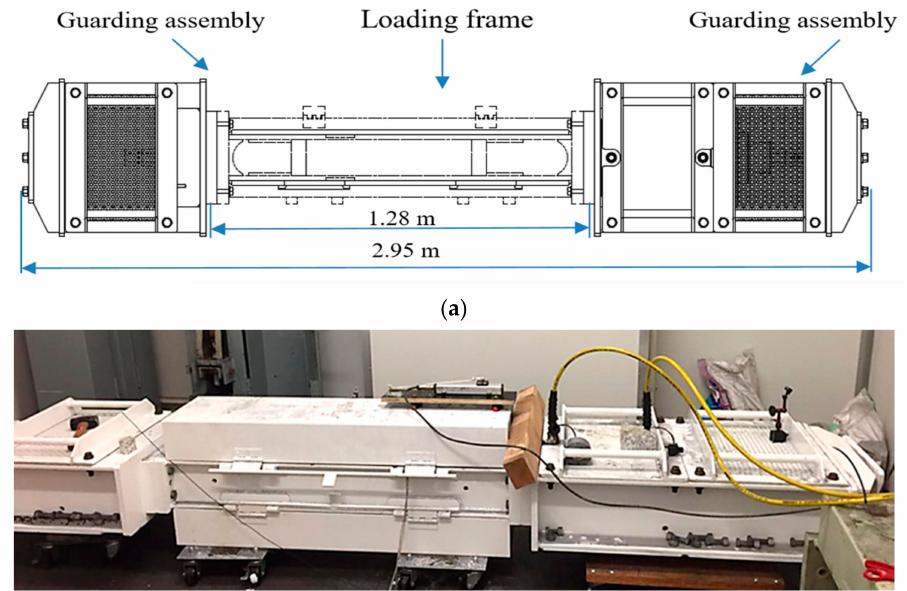
Figure 8. ( a ) Desigh of the tension-loading apparatus, and ( b ) a